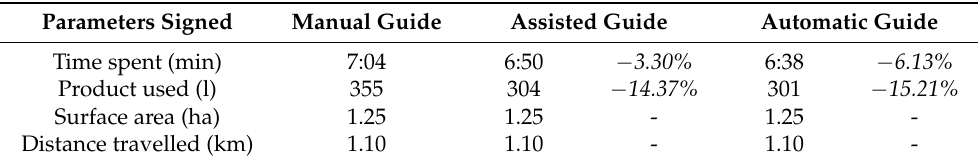
Table 2. Comparison of the parameters found in the three types of soil